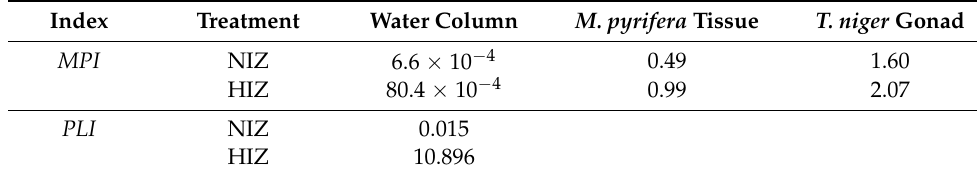
Table 1. Metal pollution index ( MPI ) and pollution load index (PLI) values determined in the water column, algal tissue, and sea urchin gonads of Algarrobo (NIZ) and Caleta Horc ó n (HIZ), as applicable. NIZ = non-impacted zone, HIZ = highly impacted zone.